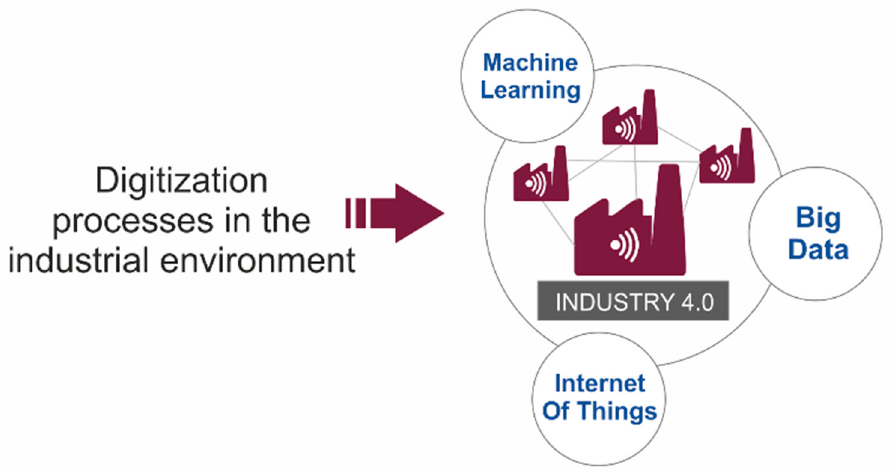
Figure 2. Three digitalization process.